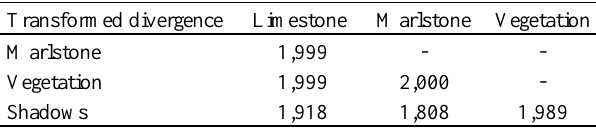
Table 4. Separability between classes (0-2)